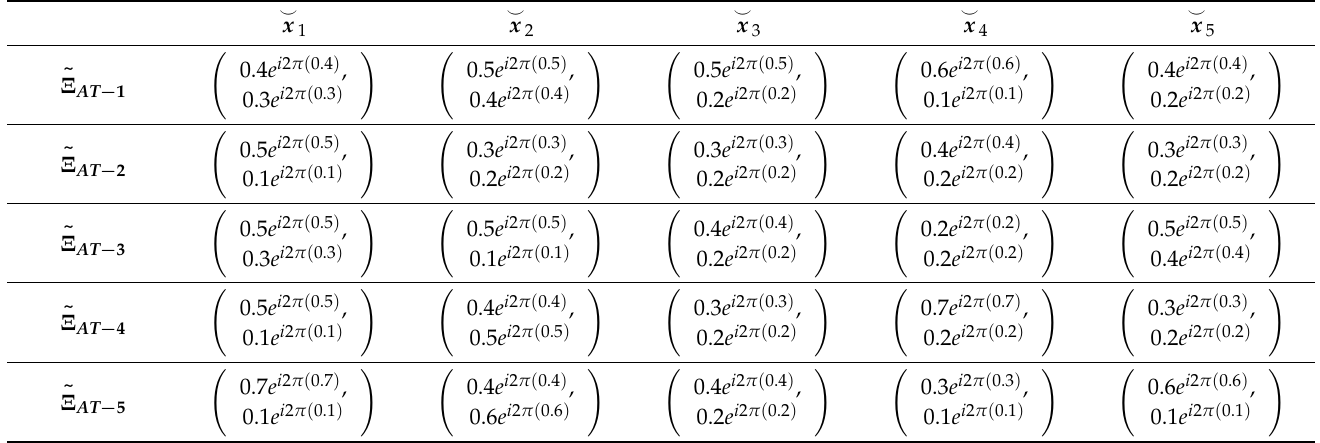
Table 4. Original decision matrix for candidates (cid:101) Ξ CI − 3